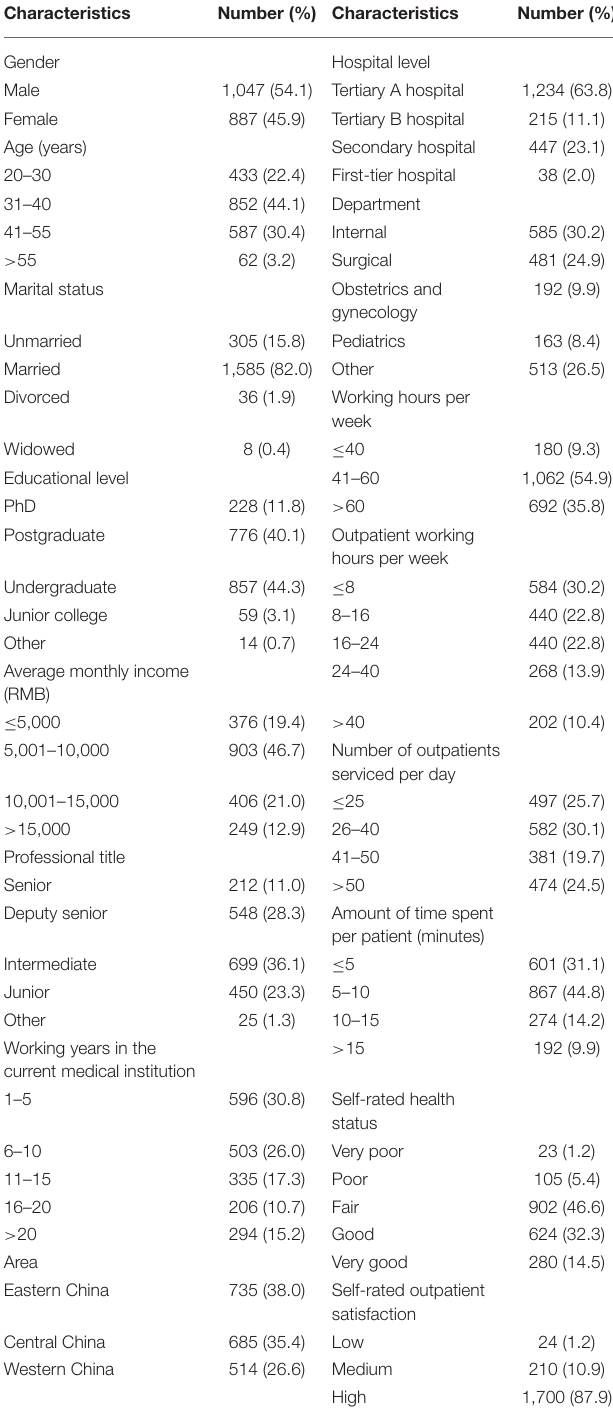
TABLE 1 | Demographic characteristics of the participating physicians ( N =